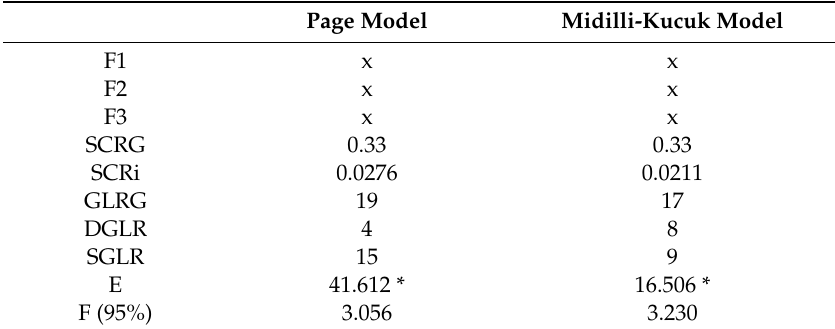
Table 3. Statistical comparison among grapefruit formulations (F1, F2, and F3) obtained according to Table 1 in terms of the fitted models. Page Model